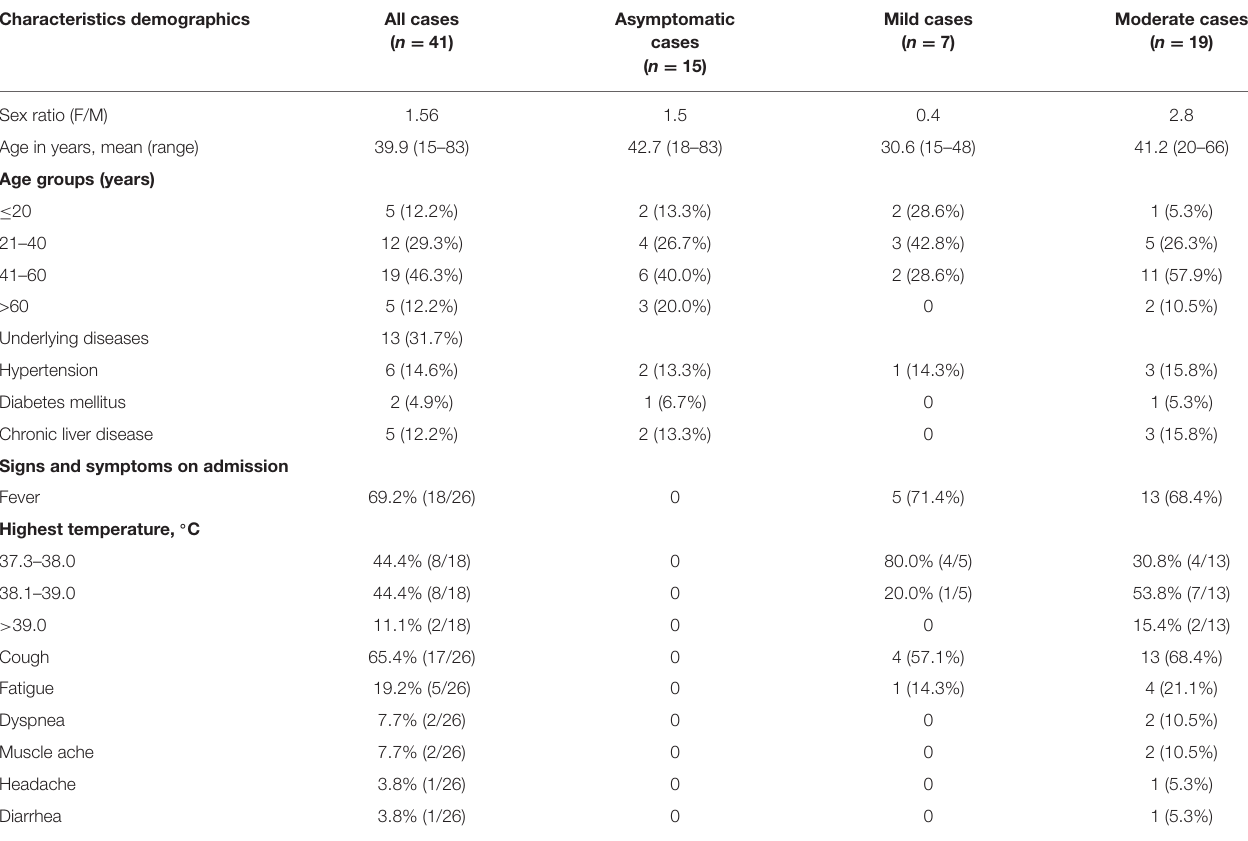
TABLE 1 | Demographics, underlying diseases, and signs and symptoms on admission of 41 patients with COVID-19: 15 asymptomatic, 7 mild, and 19 moderate cases. Characteristics